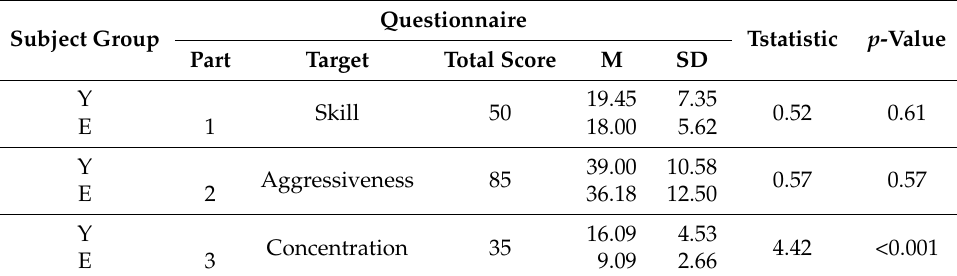
Table 2. Questionnaire